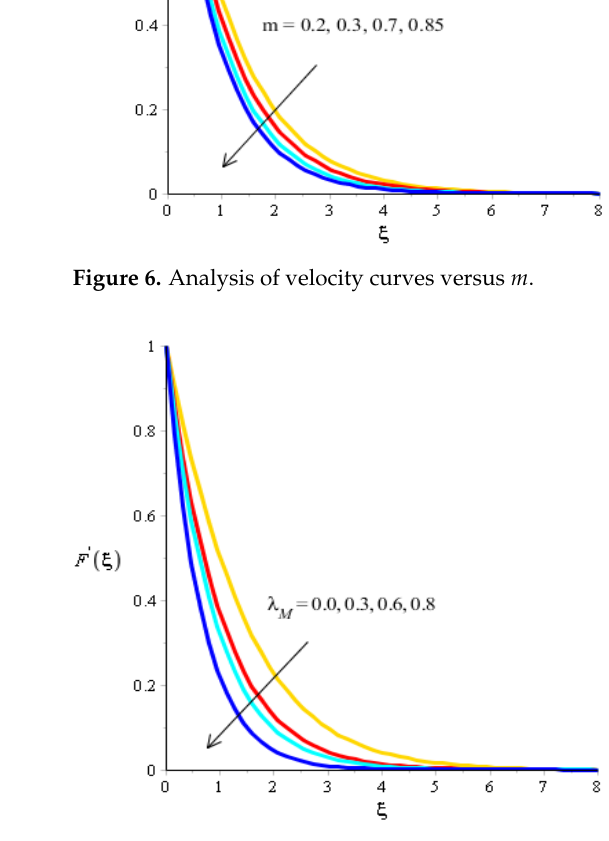
Figure 7. Analysis of velocity curves versus λ M .